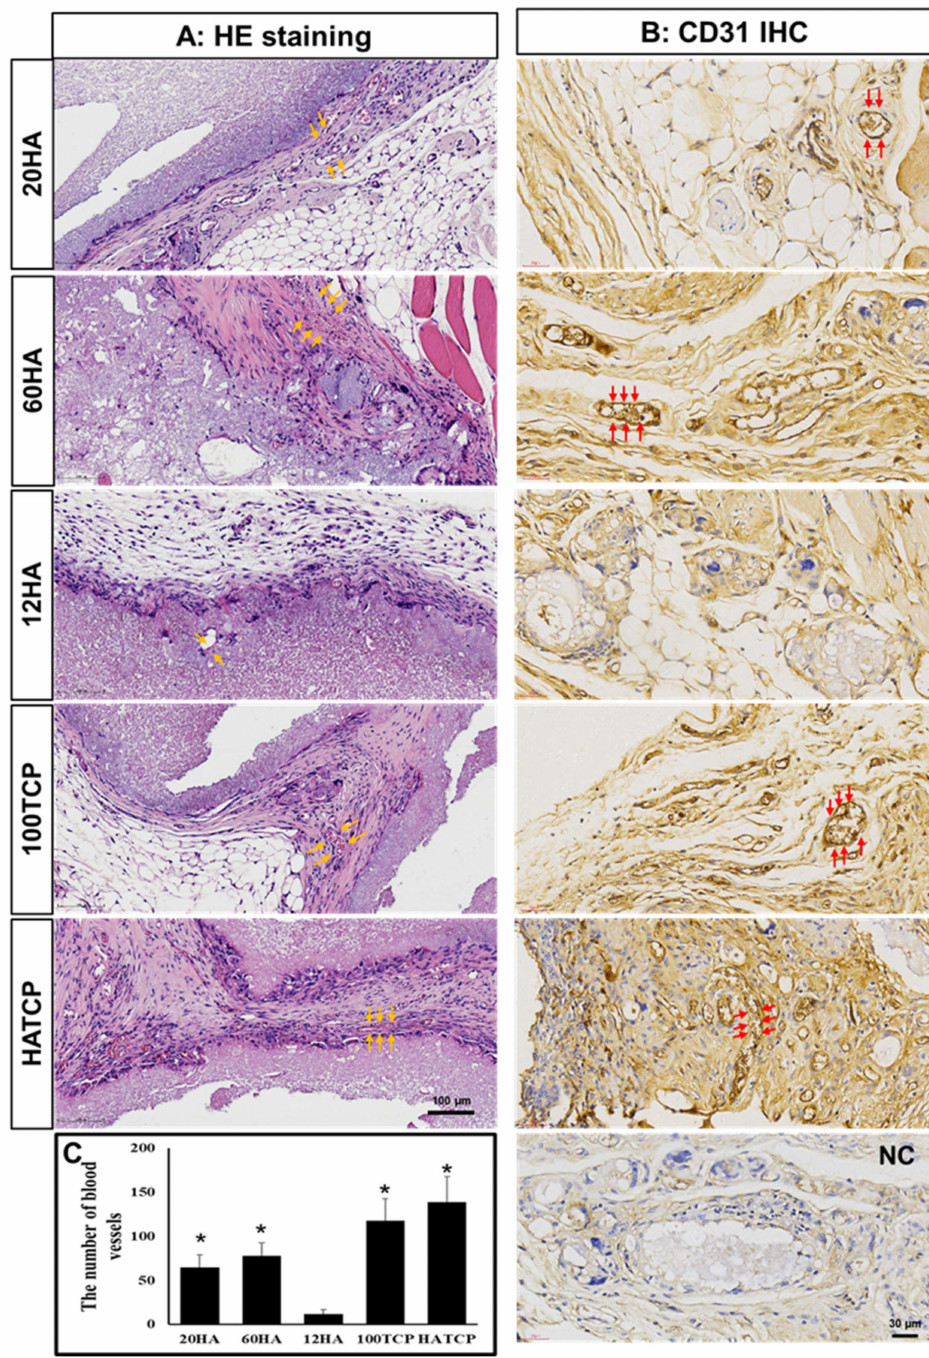
Figure 3. Angiogenesis observed following morphologic staining. ( A ) HE staining shows new-blood- vessel formation in groups 20HA, 60HA, 12HA, 100TCP and HATCP. Arrow: blood vessels; bar: 100 µ m. ( B ) Immunohistochemical staining for CD31 shows that blood vessels were stained brown. NC: negative control; arrow: blood vessels; bar: 30 µ m. ( C ) The number of blood vessels in the five groups was counted based on IPP software; * p <